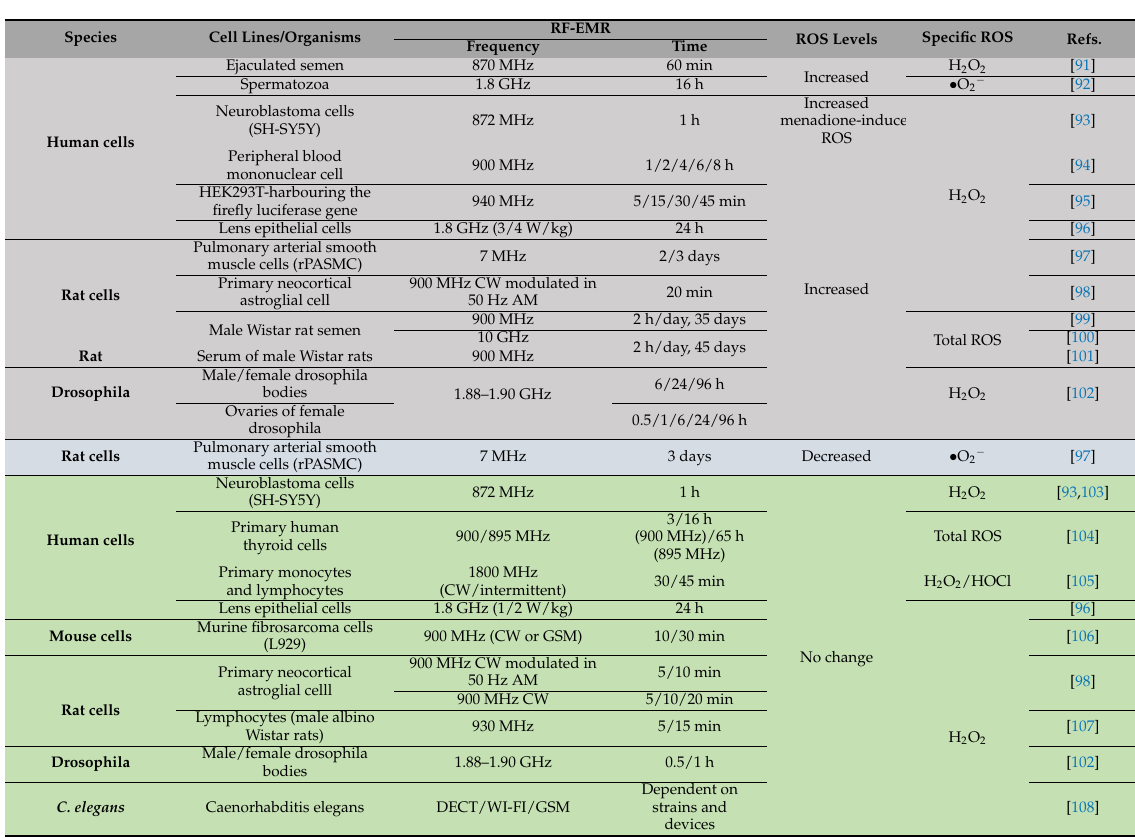
Table 5. ROS changes induced by radio frequency electromagnetic radiations